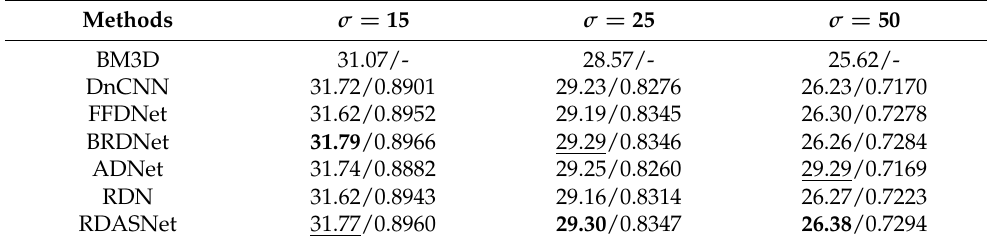
Table 3. PSNR (dB) and SSIM of different methods on the BSD68 for different noise levels (i.e., 15, 25, and 50). The best PSNR two results are shown in bold and underlined,